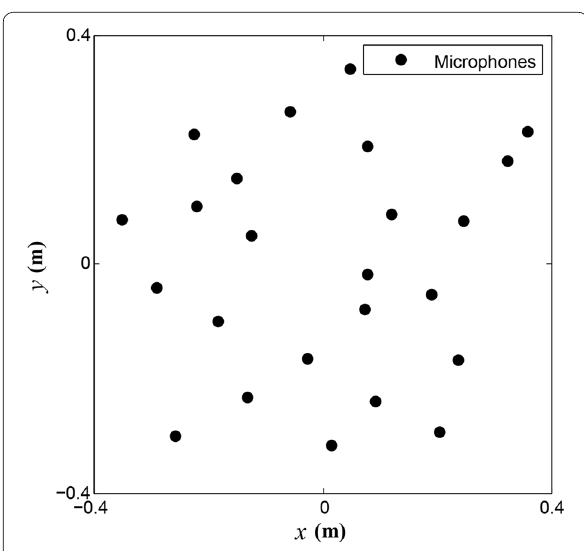
Figure 10 A 24-channel microphone array